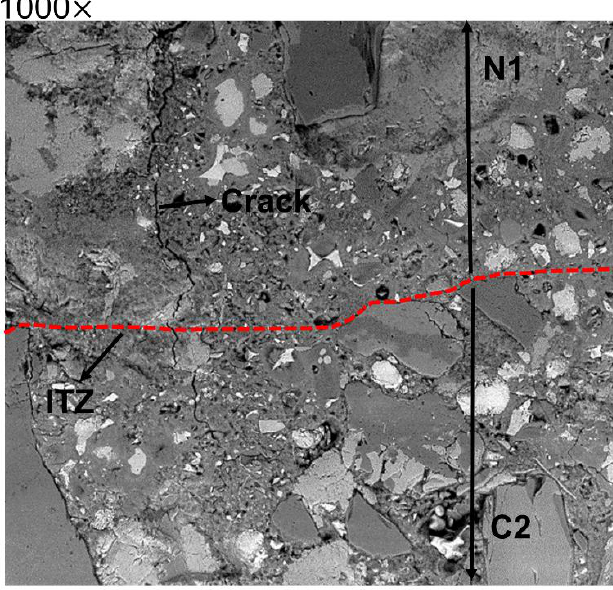
Figure 6. SEM images at 100 × of N1C2 where the crack is formed on the N1 matrix and continues to Figure 6 . SEM images at 100× of N1C2 where the crack is formed on the N1 matrix and continues to the C2 the C2 matrix.